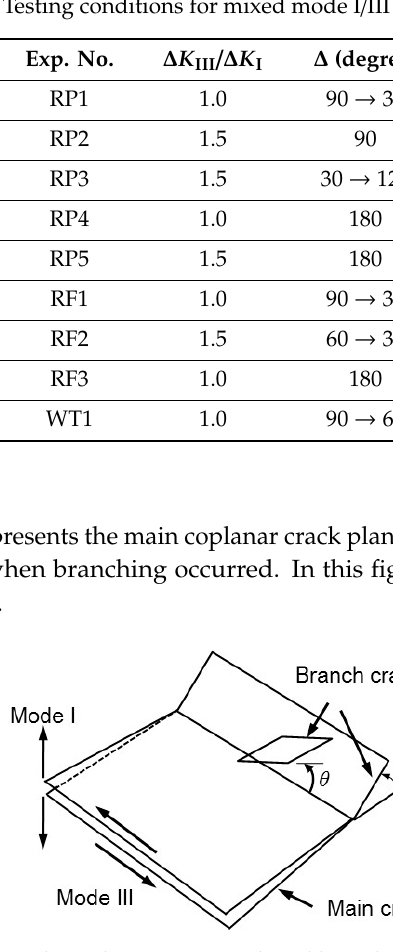
Figure 5. Branch crack at a main crack and branch angle definition.